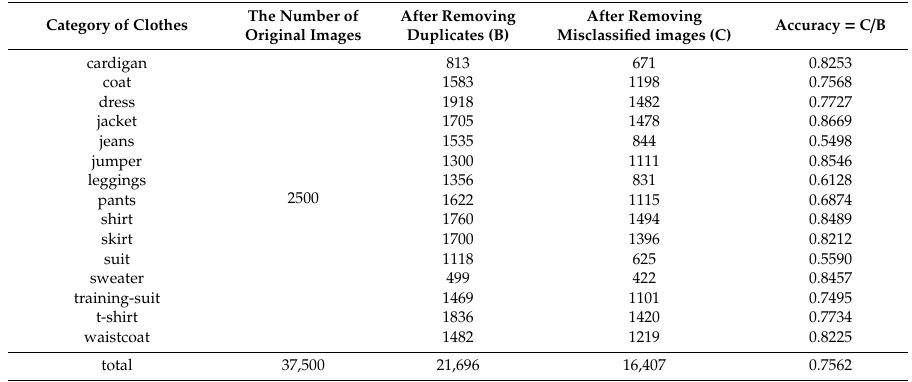
Table 8. Accuracy of the collected images of women’s clothes after the removal of